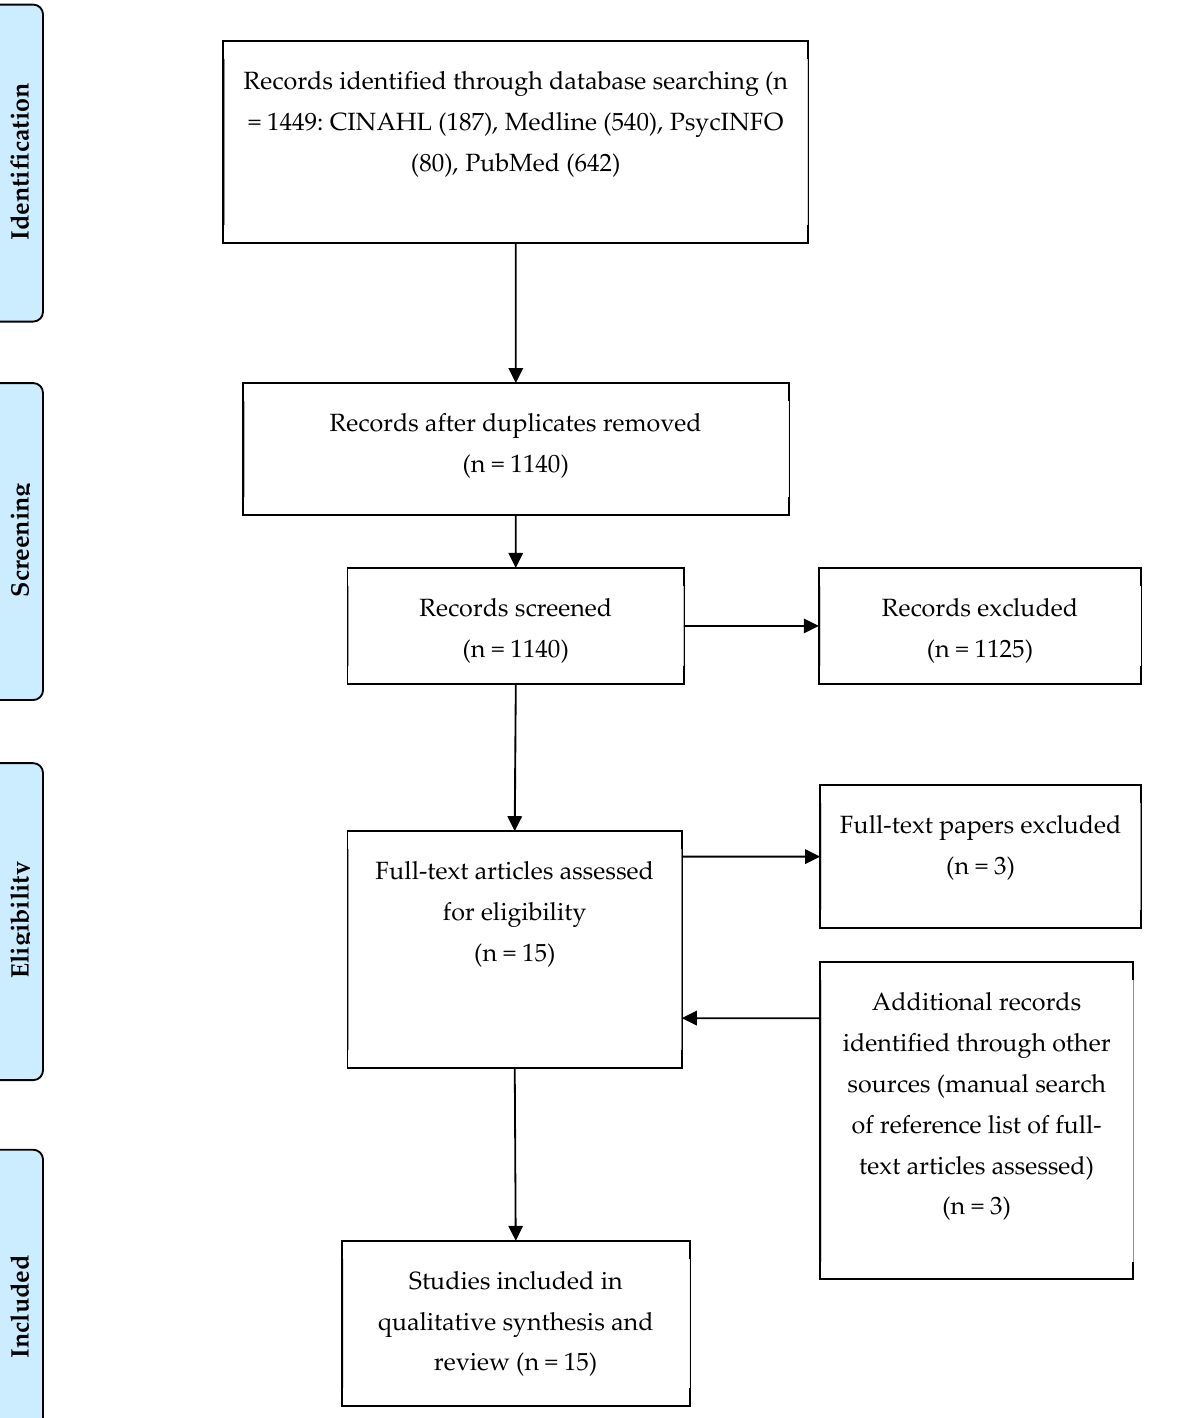
Figure 1. PRISMA 2009 flow diagram. From: Moher D, Liberati A, Tetzlaff J, Altman DG, The PRISMA Group (2009). Preferred Reporting Items for Systematic Reviews and Meta-Analyses: The PRISMA Statement. PLoS Med 6(7): e1000097. doi:10.1371/journal.pmed1000097.